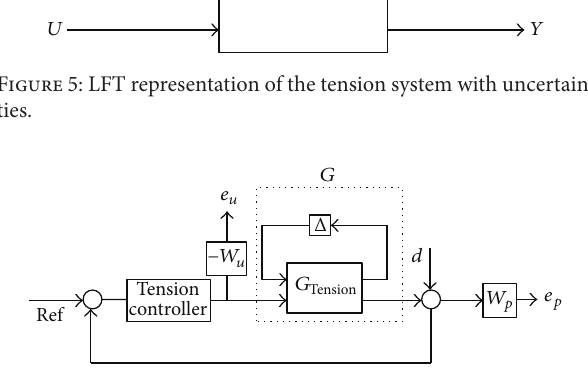
Figure 6: The block diagram of closed system with performance